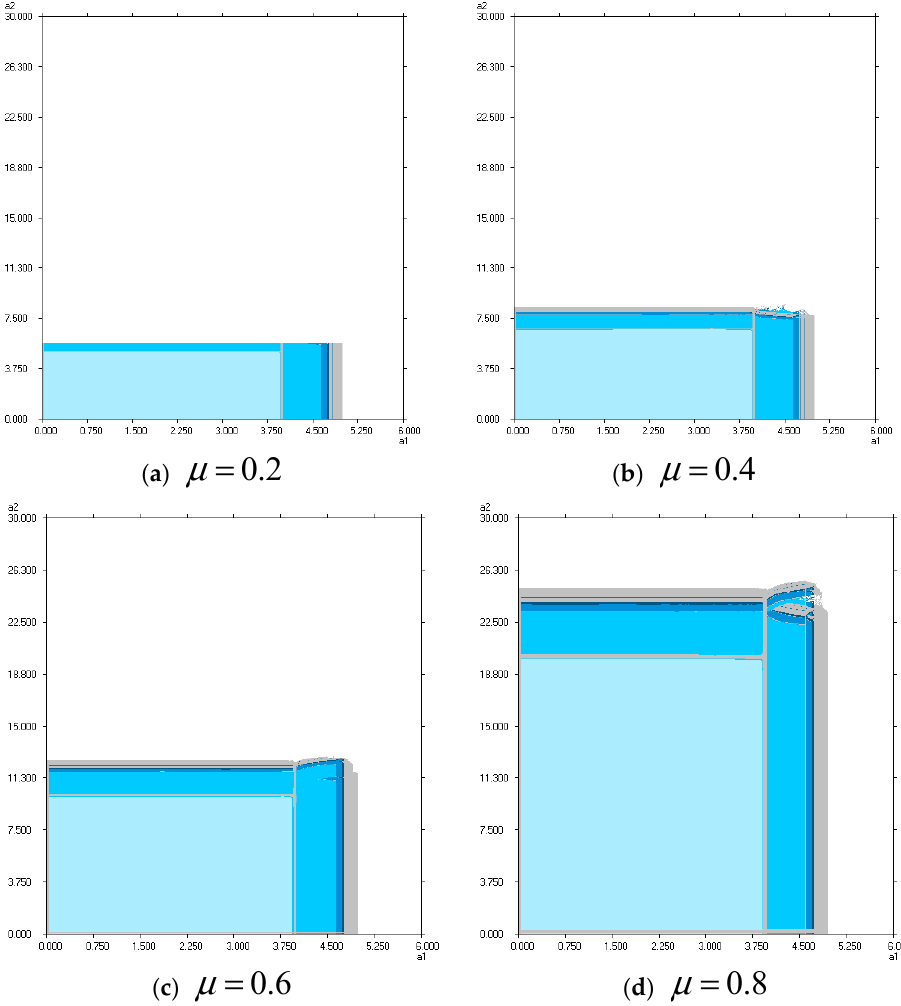
α α μ and with different . 1 2